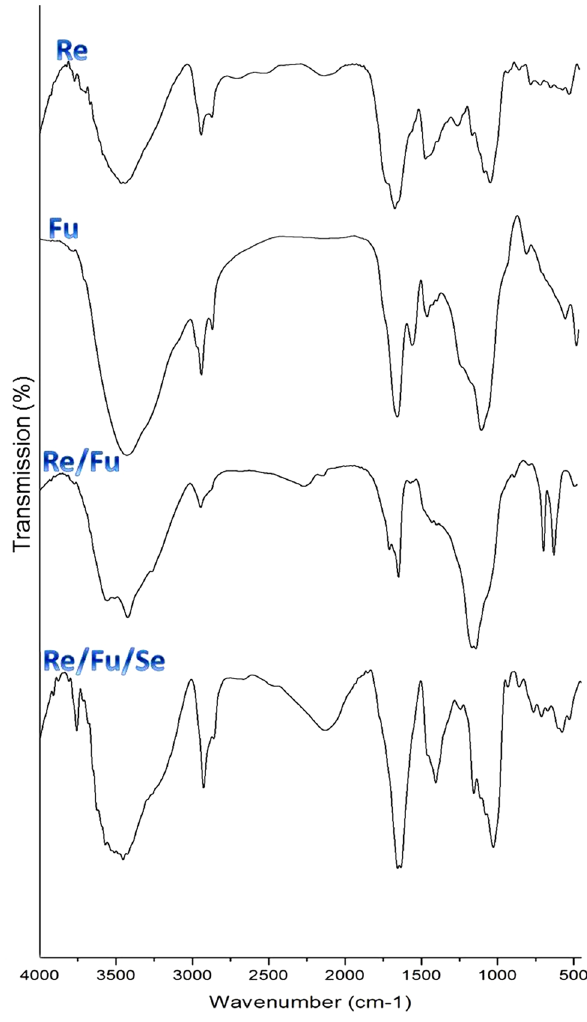
Figure 2: FTIR spectra of Re, Fu, composited Re/Fu, and composited Re/Fu with SeNPs ( Re/Fu/Se )